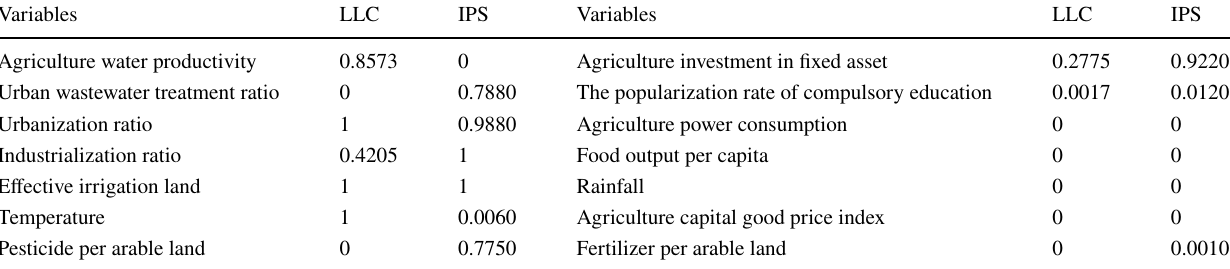
Table 3 Stationary test result Variables